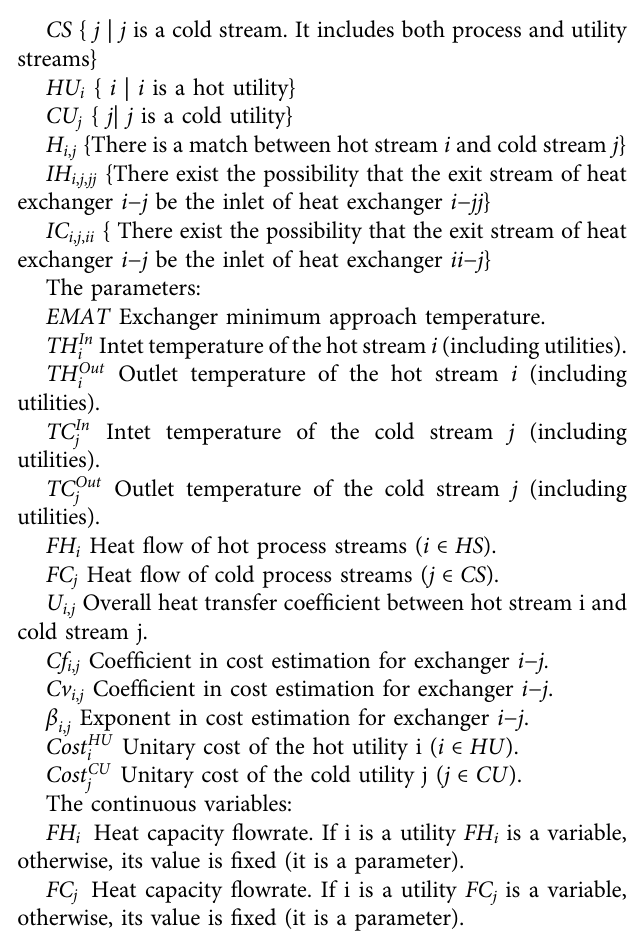
Frontiers in Chemical Engineering |